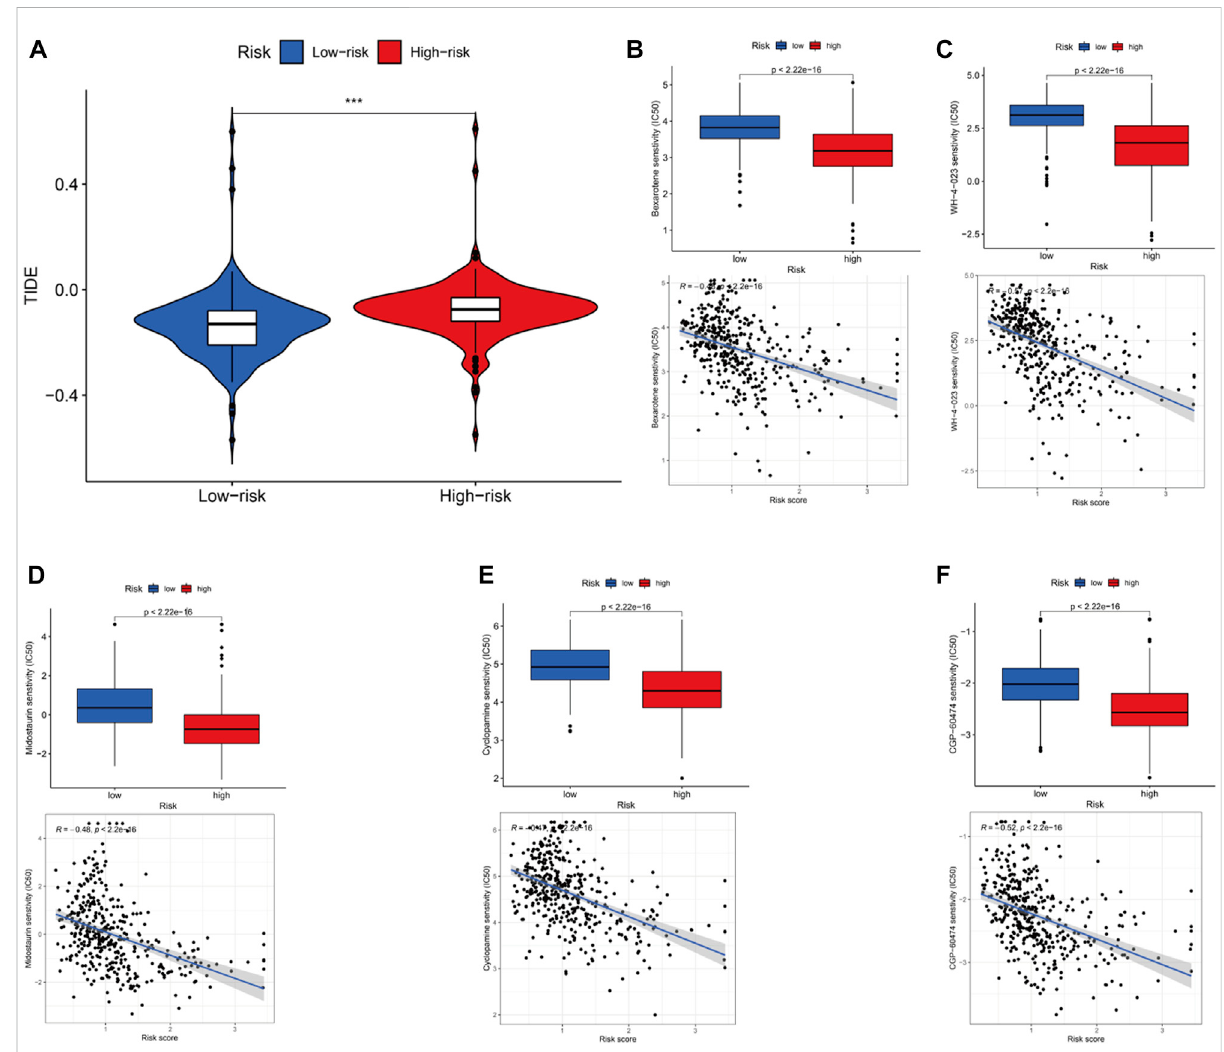
Immunotherapy, drug sensitivity and the relationship between the drug sensitivityand risk scores. (A) .Different TIDE in the high and low groups. Observedthedrugsensitivityanditsrelationshipwithriskscoresintop5drugs:Bexarotene (B) ,WH-4-023 (C) ,Midostaurin (D) ,Cyclopamine (E) and CGP-60474 (F)